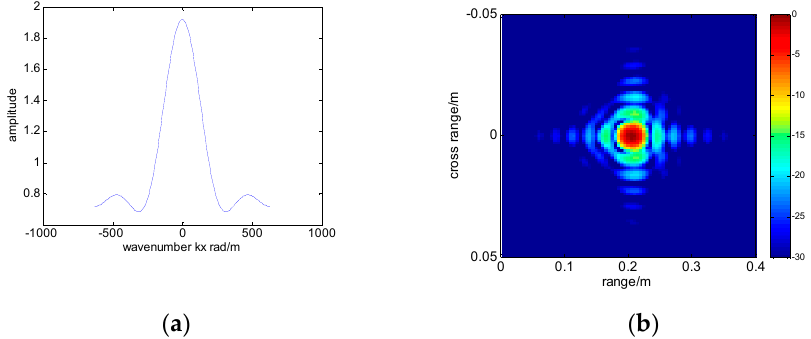
Figure 7. The array calibration factor and the imaging result after calibration, ( a ) is the array calibration factor and ( b ) is the imaging result after calibration.